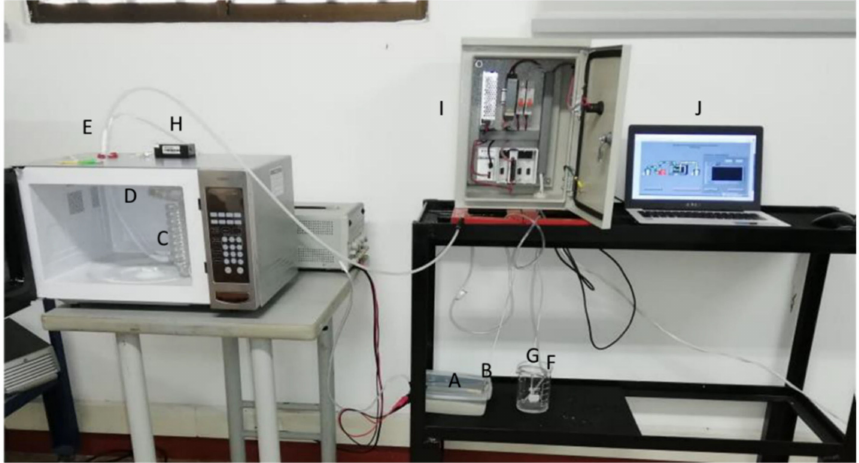
Figure 7. Assembled device. A . Input Liquid container. B . Thermocouple installed to the input liquid container. C . Glass coiling pipe. D . Bulb with temperature optical fiber sensor installed inside. E . Holes above the modified oven microwave to allow input and output of liquid. F . Output liquid container with processed liquid. G . Thermocouple installed to the output liquid container. H . FBG interrogator. I . Thermocouple measurement system. J . Visual Interface in